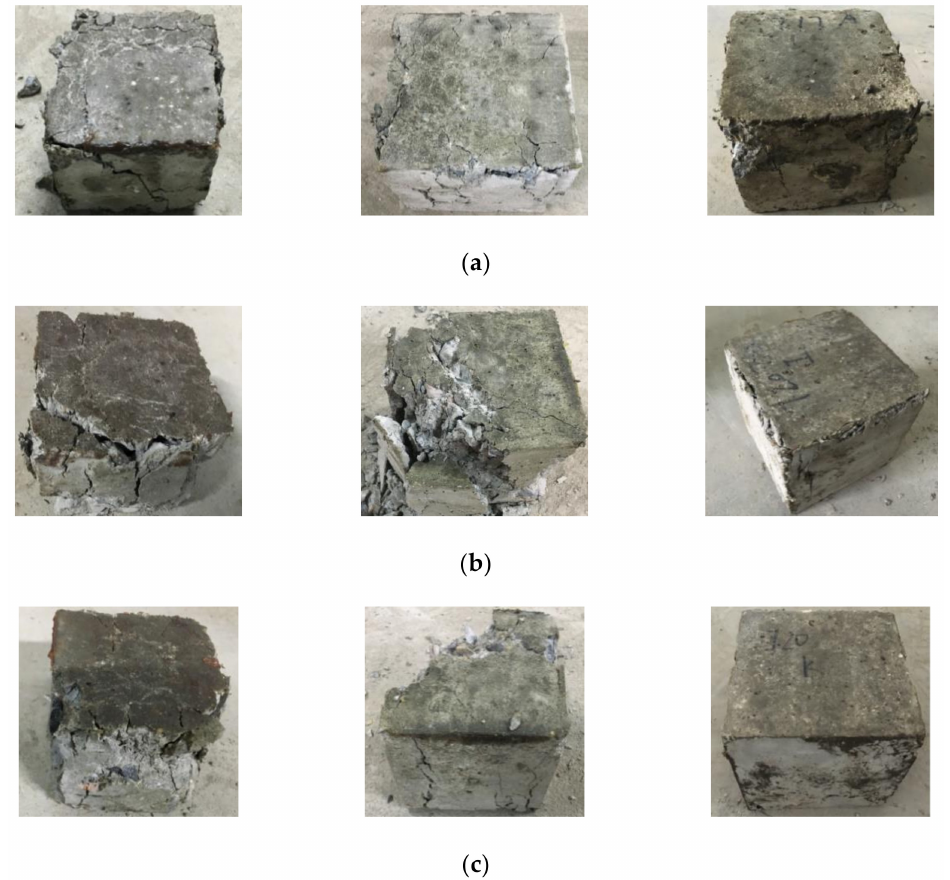
Figure 9. Compression failure modes of the recycled aggregate concrete cubes of various dimensions: ( a ) 0% substitution ratio of recycled aggregate (70 mm, 100 mm, and 150 mm); ( b ) 50% substitution ratio of recycled aggregate (70 mm, 100 mm, and 150 mm); and ( c ) 100% substitution ratio of recycled aggregate (70 mm, 100 mm, and 150